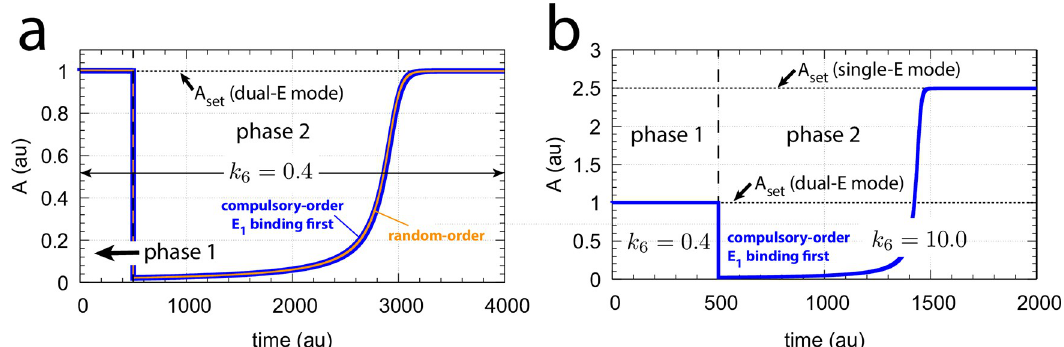
Fig 12. Dual- and single-E control mode of the m2 feedback loop when E 1 and E 2 are removed by a compulsory-order ternary complex mechanism and when E 1 binds first to Ez (Fig 11a). Panel a, outlined in blue, shows the concentration of A for the mechanism of Fig 11a with a step-wise change of k 2 from 10.0 (phase 1) to 500.0 (phase 2). For comparison, outlined in orange, the results of Fig 10b for the random-order ternary complex mechanism working in dual-E mode are shown. Rate constant k 6 =0.4 for both phases. Other rate constants and initial concentrations are the same as for Fig 10b. Panel b shows the concentration of A for the compulsory-order ternary complex mechanism from panel a, but k 6 is changed in phase 2 from 0.4 to 10.0. The controller switches in phase 2 from dual-E mode to single-E mode with the associated change of A from 1.0 (Eq 14) to 2.5 (Eq 15). Initial set concentrations and rate constants as in panel a.